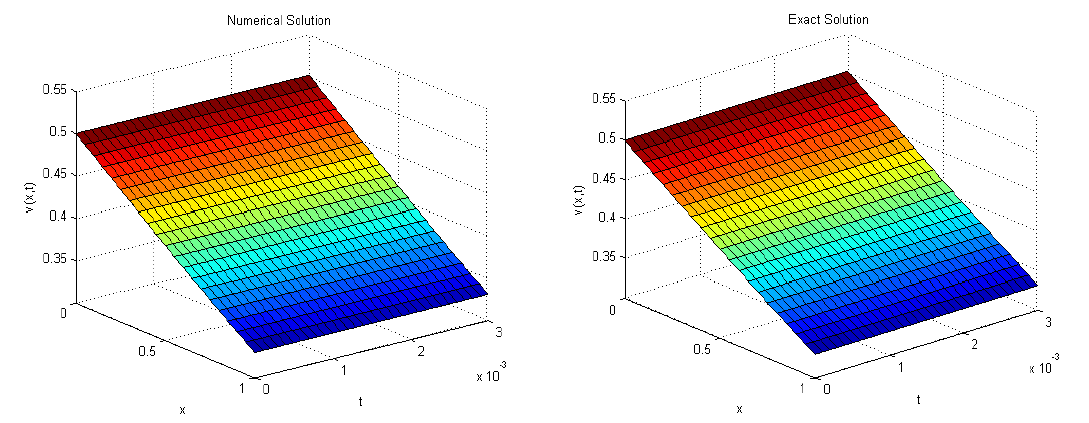
Figure 4. Comparison of results obtained in Example 2 with 𝜁 = 1 for 𝑡 ≤ 0.003